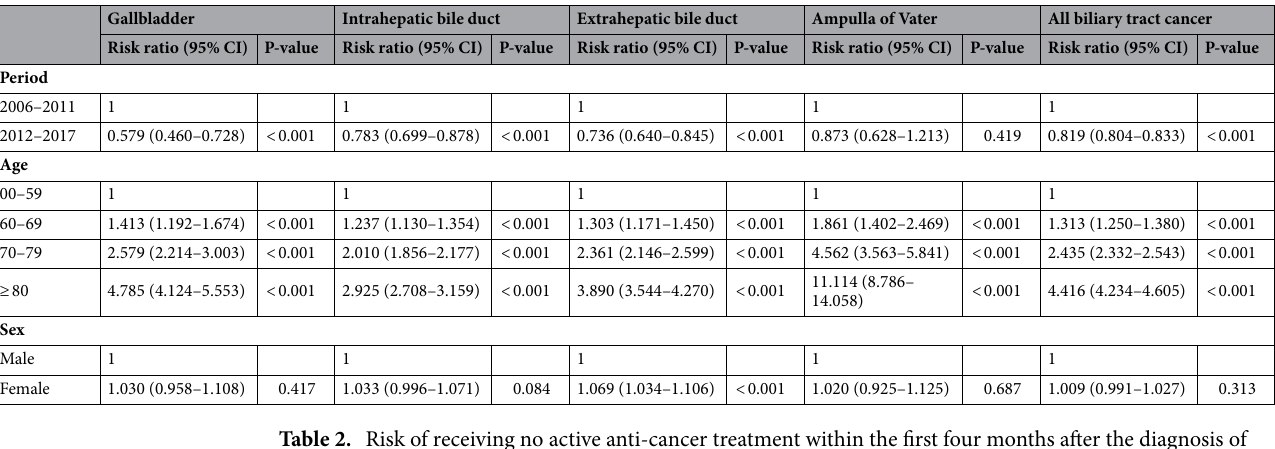
Table 2. Risk of receiving no active anti-cancer treatment within the first four months after the diagnosis of localized and regional biliary tract cancer according to the tumor location.